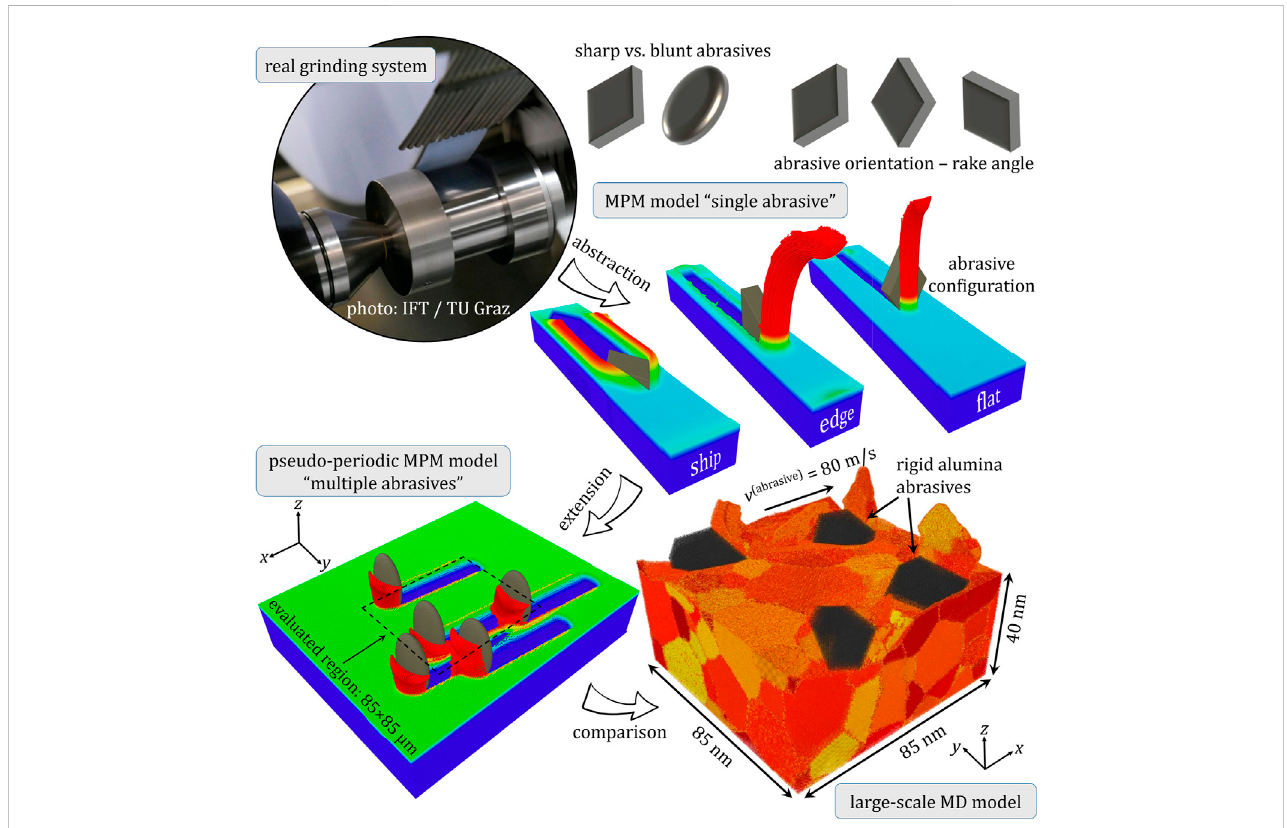
FIGURE 1 System and work fl ow overview. Top left: a real macroscopic grinding system. Top right: abstraction of the real system to an MPM model of single- abrasive grinding. Exemplary sketches of the varied parameters: Abrasive shape, orientation, con fi guration, and infeed depth. Bottom left: Extension of the single-abrasiveapproachtoapseudo-periodicmulti-abrasivesystem.Bottomright:Comparisonandqualitativevalidationwithascaled-downpolycrystalline molecular dynamics version of a multi-abrasive system. All 3D-visualizations were produced using OVITO (Stukowski and Albe,